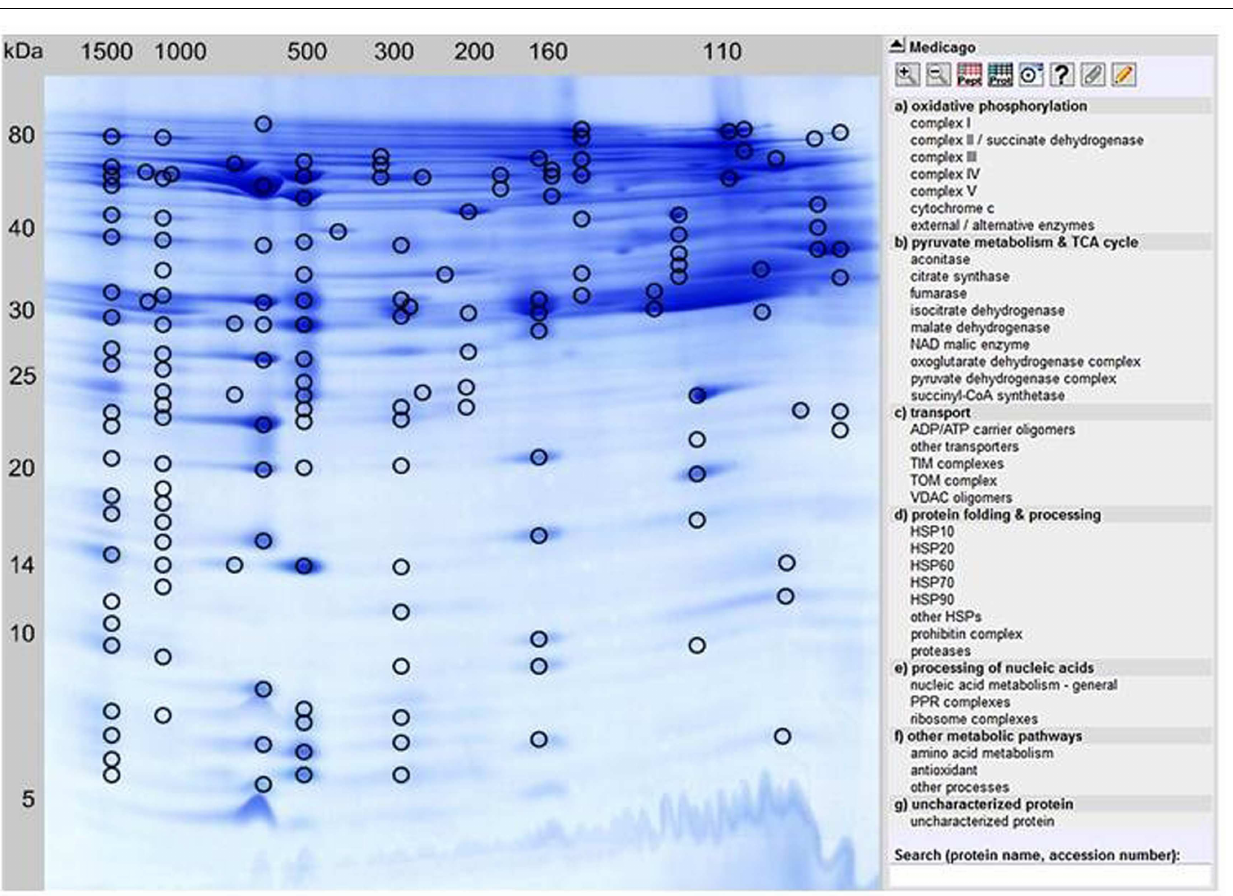
FIGURE 1 | GelMap reference map of the M. truncatula mitochondrial protein complexe proteome/complexome (http://www.gelmap.de/ medicago/). Hundred and fifty-eight protein spots separated by 2D BN/SDS-PAGE and identified by MS are marked by circles. Most protein spots include multiple protein annotations. By clicking a certain protein spot, all identified proteins within this spot are shown in a pop-up window, beginning